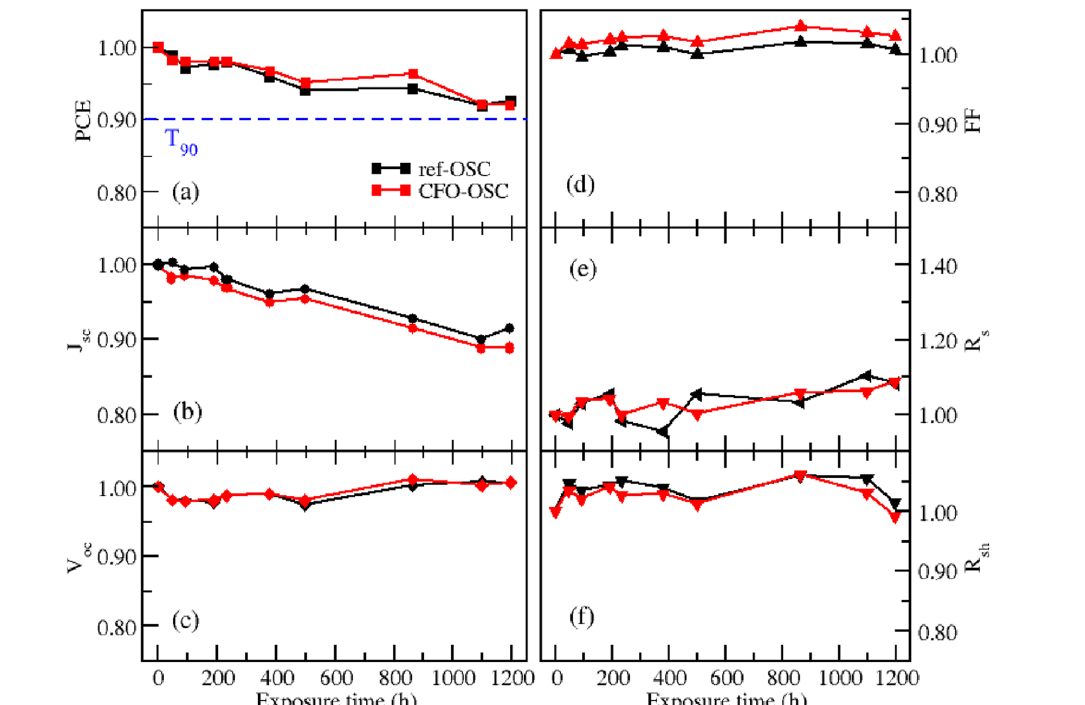
, (c) V , (d) FF, (e) R and(f) R of ref-OSC (black) and CFO-OSC (red) devices. sc oc s sh